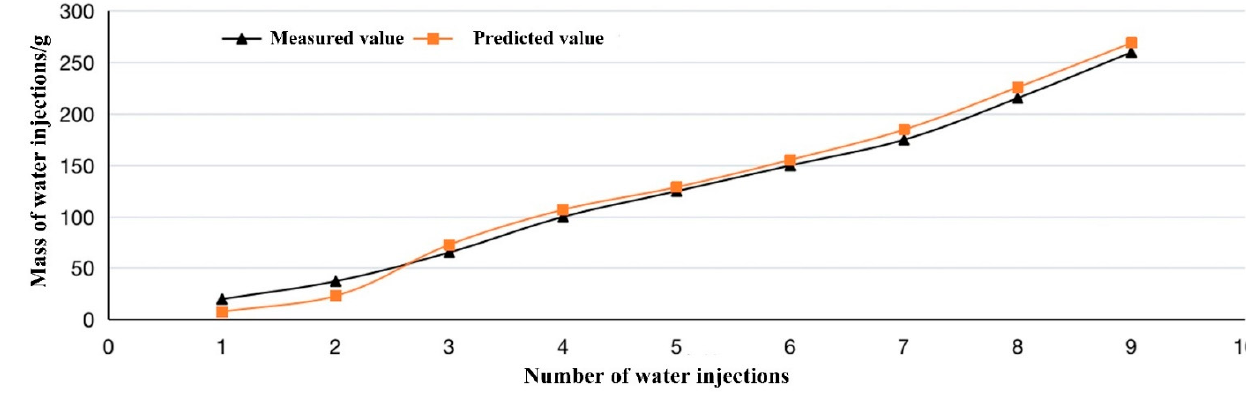
Figure 6. Prediction performance of LR model.